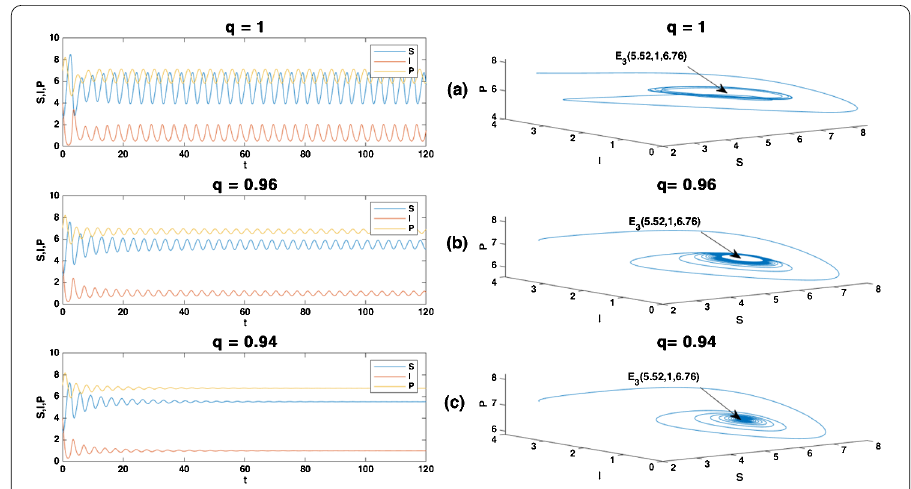
Figure 17 Time series and phase diagram of the fractional-order model (3) with different values of fractional order ( q )